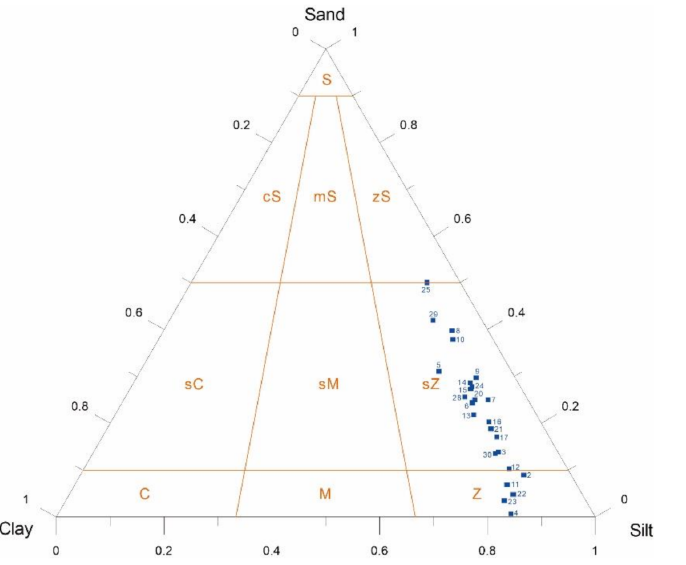
Figure 3. Classification of surface sediment types on the southwestern Sunda Shelf according to grain size composition. The abbreviations S, cS, mS, zS, sC, sM, sZ, C, M, and Z represent sand, clayey sand, muddy sand, silty sand, sandy clay, sandy mud, sandy silt, clay, mud, and silt, respectively. The average particle diameter (Mz) ranged from 4.30 Φ to 6.37 Φ (average of 5.41 Φ ). High Mz values (>5.7 Φ ) were mainly observed on the outer Sunda Shelf to the north and east, while low Mz values (<5.1 Φ ) were observed along the coast of the Malay Peninsula (Figure 2e). The sorting coefficient (sort), skewness (skew), and kurtosis values (kurt) varied from 1.52–2.69 Φ , 0.60–1.82, and 2.09–3.32, respectively, with average values of 1.87, 1.42, and 2.51, respectively. High sort values (>2.1 Φ ) were mostly observed in